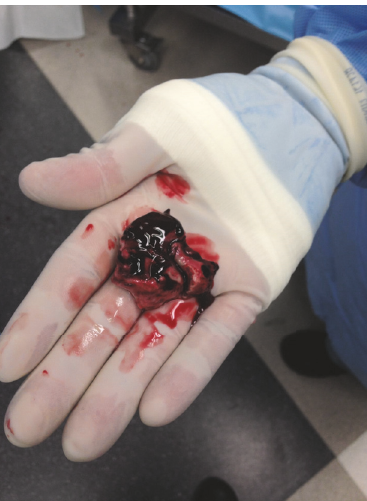
Figure 2: Confluent, white mass seen on initial resection, the pathology of which returned as myeloid sarcoma.